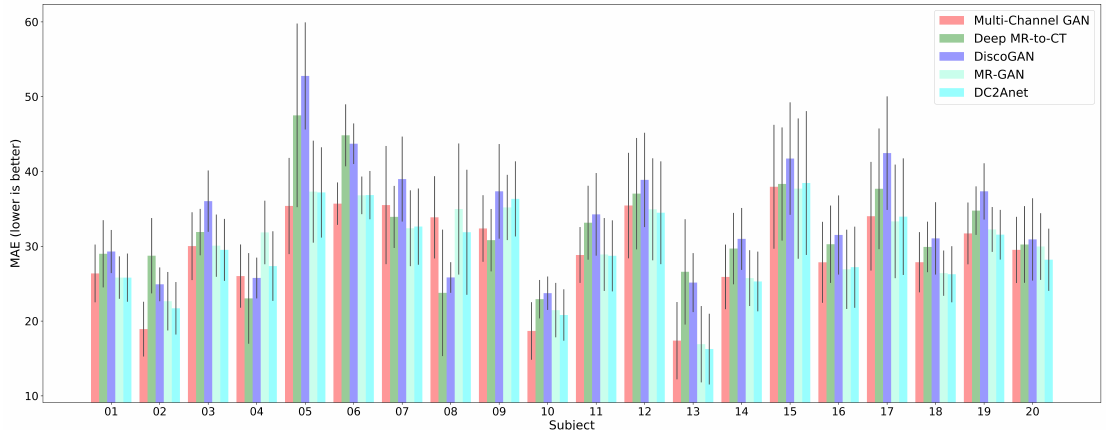
Figure 7. MAE computed for the first 20 of the 92 subjects in the test